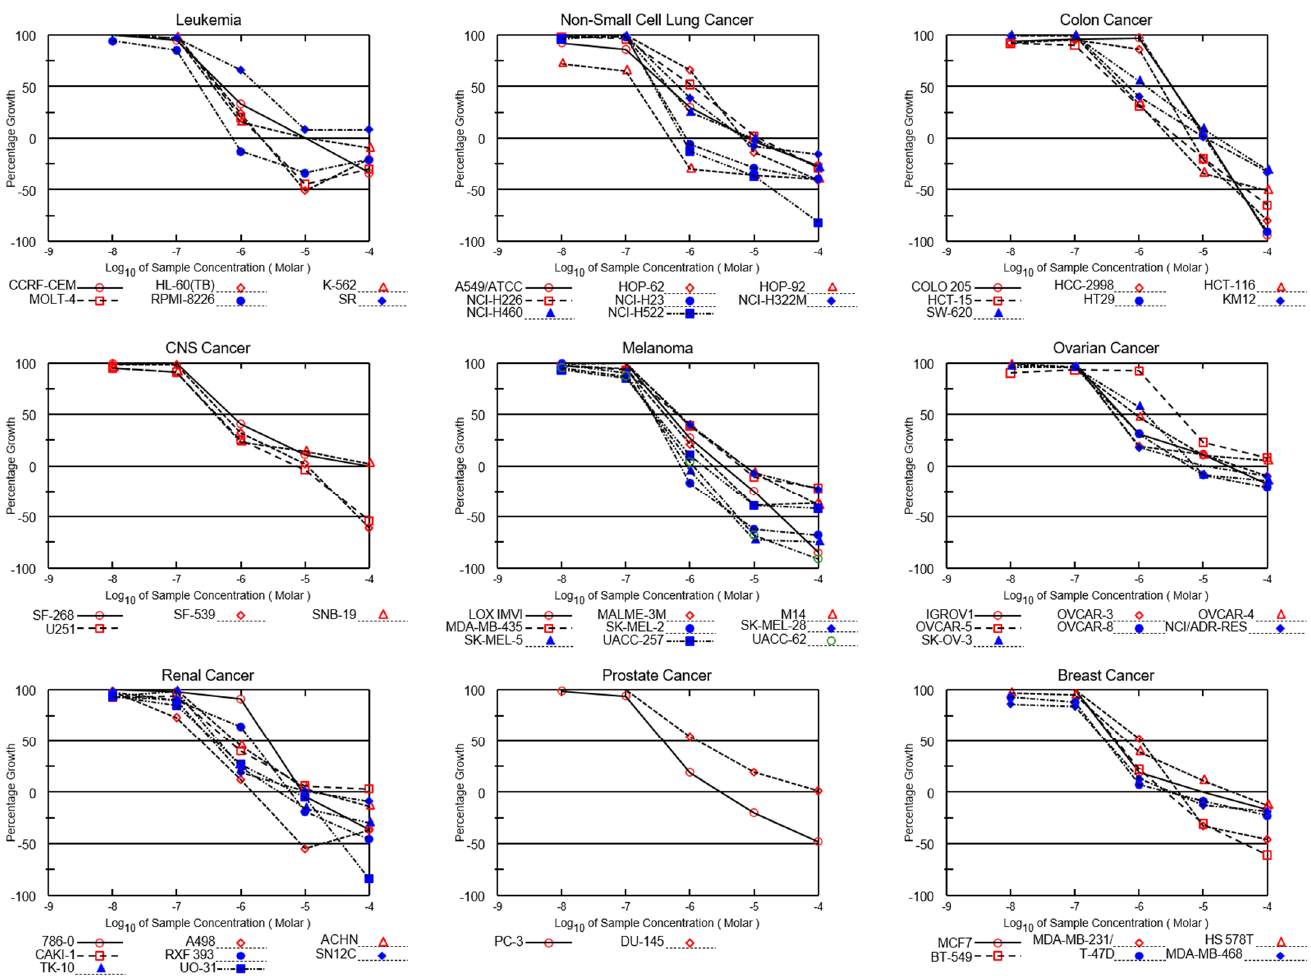
Figure 3. Dose–cytotoxic response curves of NSC765690 against panels of 60 NCI human cancer cell lines. The growth percentage value of +100 on the Y-axis represents the growth of untreated cells, the 0 value represents no net growth, while −100 represents the complete death of cells.